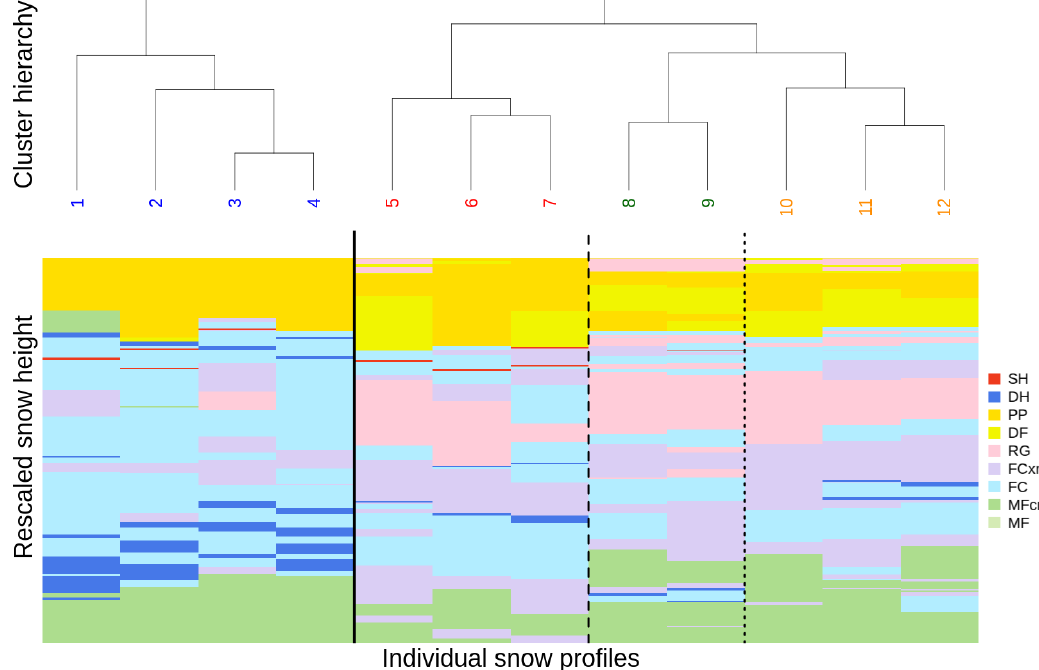
Figure 4. Hierarchical clustering of 12 snow profiles based on prior snow profile alignment and similarity assessment. The colors represent the grain types of distinct layers, and the bold black lines separate the four most distinct